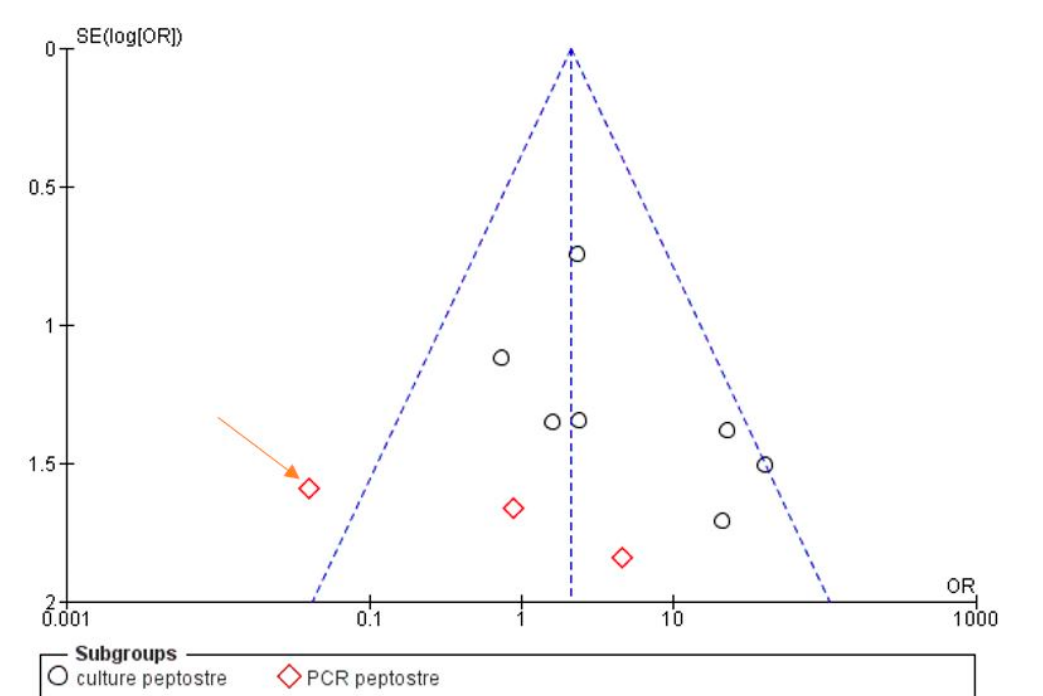
Figure 3. Funnel plot for the sub-group Propionibacterium, I 2 = 56%. The presence of heterogeneity is highlighted graphically. The arrows highlight the sources of heterogeneity A: Fukushima, 1990; B: Sunde, 2002. Sub-group culture I 2 = 64%. Sub-group PCR I 2 = 5%. The heterogeneity between the two sub-groups is I 2 = 13%.